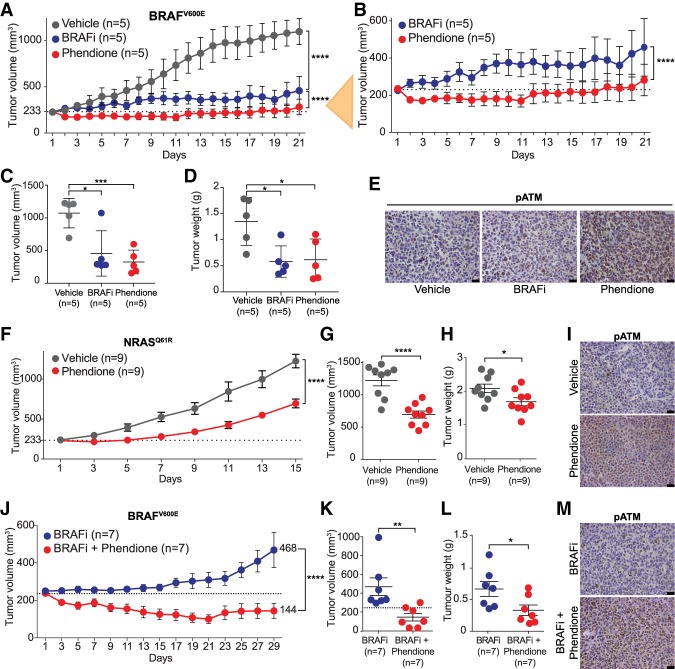
Phendione inhibits growth of human tumors with BRAF or NRAS mutations and overcomes resistance to BRAF inhibition in vivo. (A,B) Tumor volume of BRAFV600E PDXs treated with BRAFi (dabrafenib) at 30 mg/kg daily by oral gavage, or phendione at 5 mg/kg every 2 d intraperitoneally (i.p.); vehicle was used as control in A. Zoomed-in curves of BRAFi and phendione treatments are shown in B. Data are mean ± SEM, n = 5. (****) P < 0.0001, by two-way ANOVA with Tukey's multiple comparisons test. Dotted line in A and B indicates the tumor volume on the day of treatment started. (C,D) Dot plots of BRAFV600E PDX tumor volume (C) and weight (D) at day 21. Data are mean ± SEM. (*) P < 0.05; (***) P < 0.001; (****) P < 0.0001, by unpaired two-tailed Student's t-test. (E) Representative images of immunohistochemistry staining with antibody against phospho-ATM (S1981) for BRAFV600E PDXs treated as indicated. (F) Tumor volume of NRASQ61R PDXs treated with phendione at 5 mg/kg every 2 d intraperitoneally (i.p.), or with vehicle. Data are mean ± SEM, n = 9. (****) P < 0.0001, by two-way ANOVA with Tukey's multiple comparisons test. (G,H) Dot plots of NRASQ61R tumor volume (G) and weight (H) at day 15. Data are mean ± SEM. (*) P < 0.05; (****) P < 0.0001, by unpaired two-tailed Student's t-test. (I) Representative images of immunohistochemistry staining with antibody against phospho-ATM (S1981) for NRASQ61R PDXs after indicated treatments. (J) Phendione prevents tumor relapse in BRAFV600E PDX model. Data are mean ± SEM, n = 7. (****) P < 0.0001, by two-way ANOVA with Tukey's multiple comparisons test. (K,L) Dot plots of tumor volume (K) and weight (L) of BRAFV600E PDXs. Data are mean ± SEM. (*) P < 0.05; (**) P < 0.01, by unpaired two-tailed Student's t-test. (M) Representative images of immunohistochemistry staining with antibody against phospho-ATM (S1981) of BRAFV600E PDXs treated as indicated. Scale bars, 25 µm.